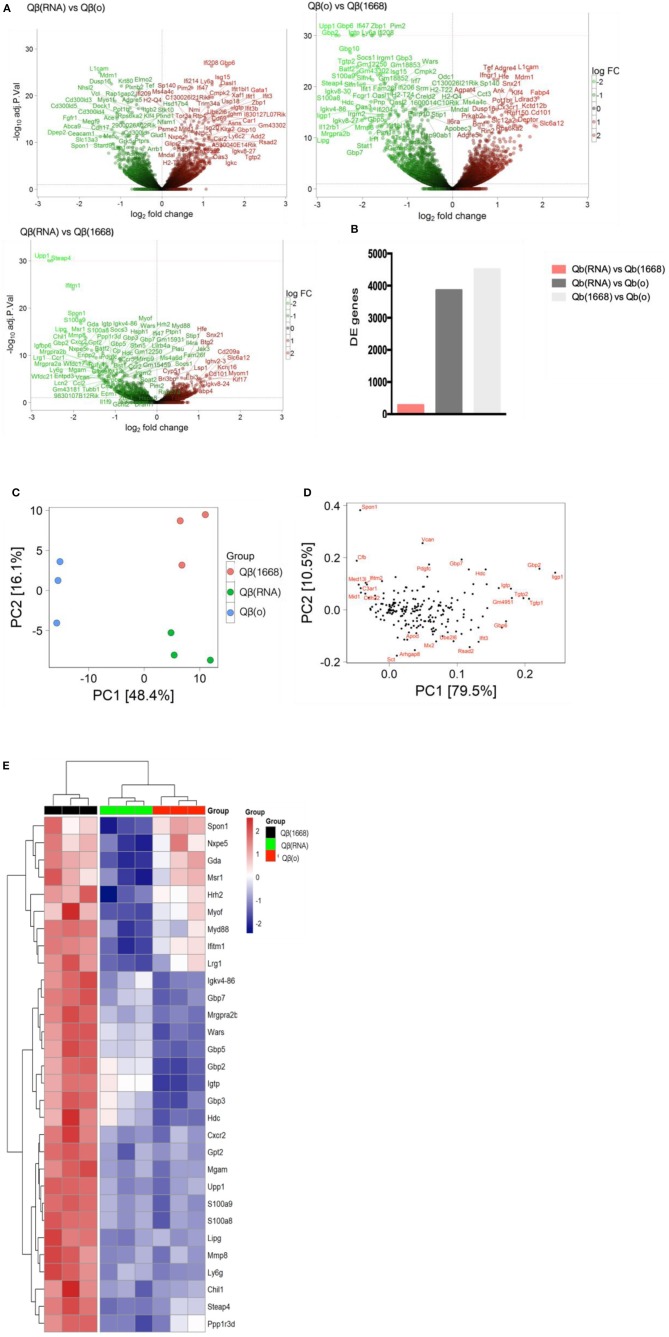
Transcriptional reprograming of DCs 24 h after immunization. (A) Volcano plot of genes differently expressed between Qβ(RNA) vs. Qβ(o), Qβ(o) vs. Qβ(1668), and Qβ(RNA) vs. Qβ(1668), respectively. Log2 fold change on the x-axis and the -Log10 p-values on y-axis. Up-regulated genes are represented in red and down-regulated gene in green. (B) Number of genes differently expressed between the groups with a FDR of 10%. (C) Principal component analysis of genes differently expressed among the groups. The effects of the principal component 1 (PC1) is shown on x-axis and principal component 2 (PC2) shown in the y-axis (D) Genes with major contribution to sample clustering. (E) top 30 differently expressed genes. Hierarchical clustering of top 30 differently expressed genes. Regularized log transformed count data were row scaled and hierarchical clustering was applied to Euclidean distances using complete linkage clustering.